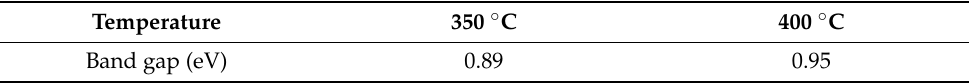
Figure 4. ( a ): (𝛼ℎ𝜈) (cid:2870) versus ℎ𝜈 . ( b ): (𝛼ℎ𝜈) (cid:2870) versus ℎ𝜈 . ( c ): (𝛼ℎ𝜈) (cid:2869)/(cid:2870) versus ℎ𝜈 . ( d ): 𝛼 versus ℎ𝜈 . Figure 4. ( a ): ( α h ν ) 2 vs. h ν . ( b ): ( α h ν ) 2 vs. h ν . ( c ): ( α h ν ) 1/2 vs. h ν . ( d ): α vs. h ν . Table 3. Exprimental band